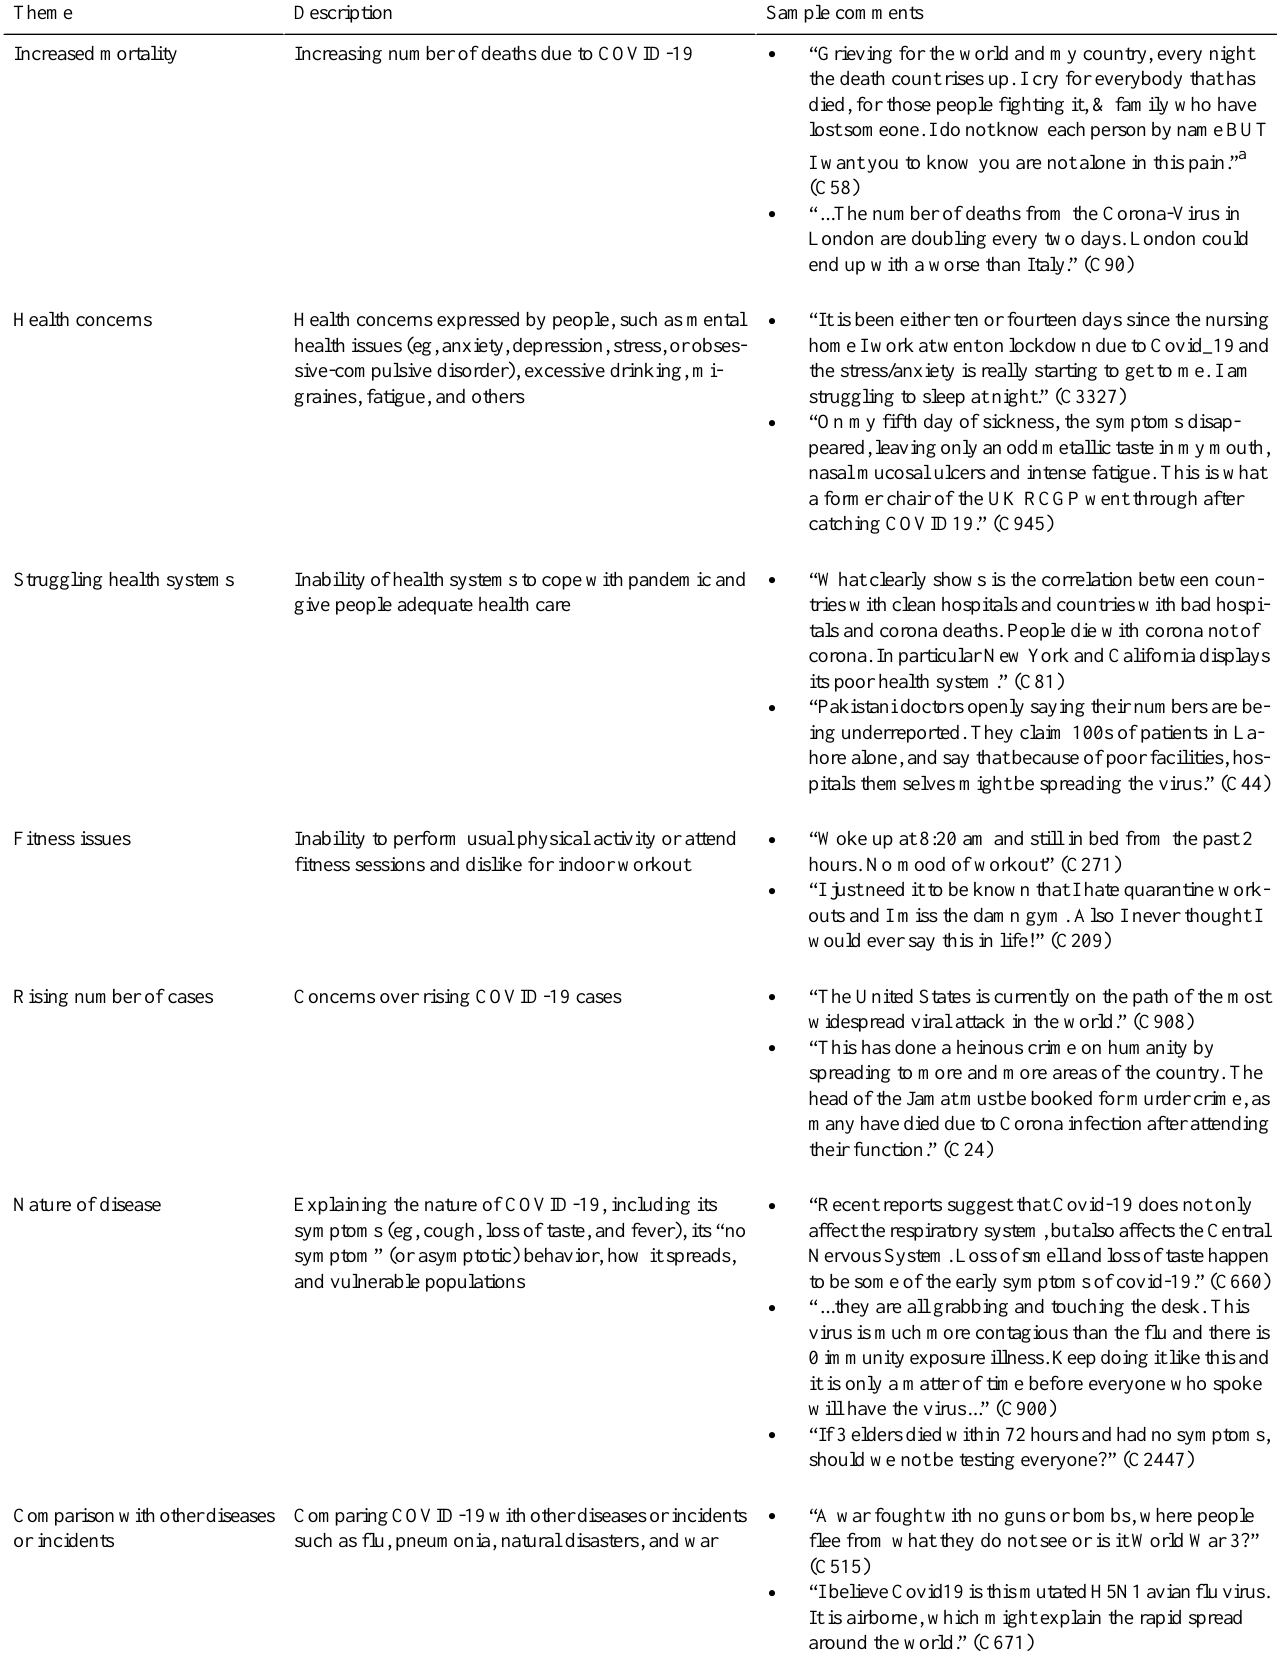
Table 2. Health-related issues: negative themes, descriptions, and corresponding sample